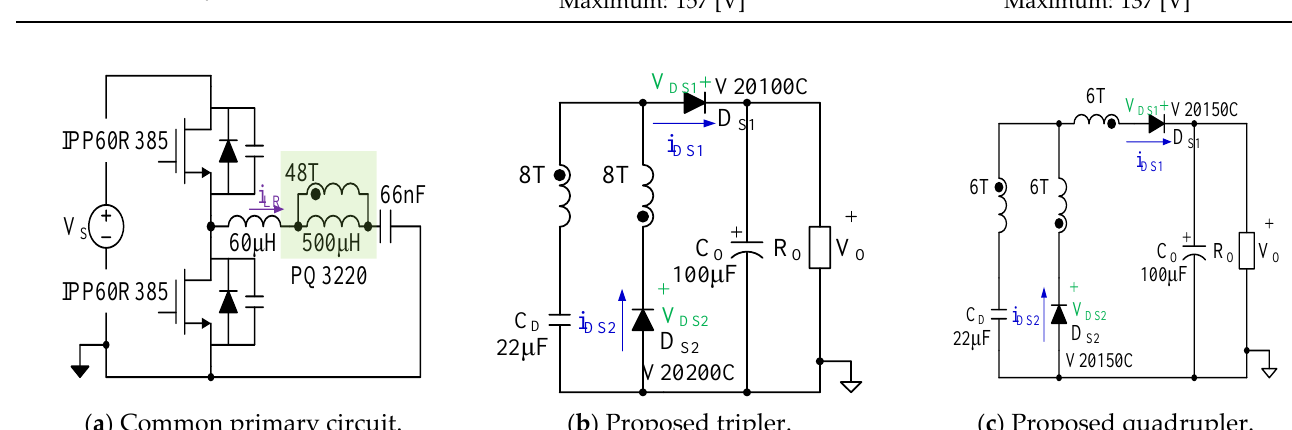
Figure 5. Experimental circuits of HB LLC resonant converter. Table 5. Specifications and components used in experimental prototype.